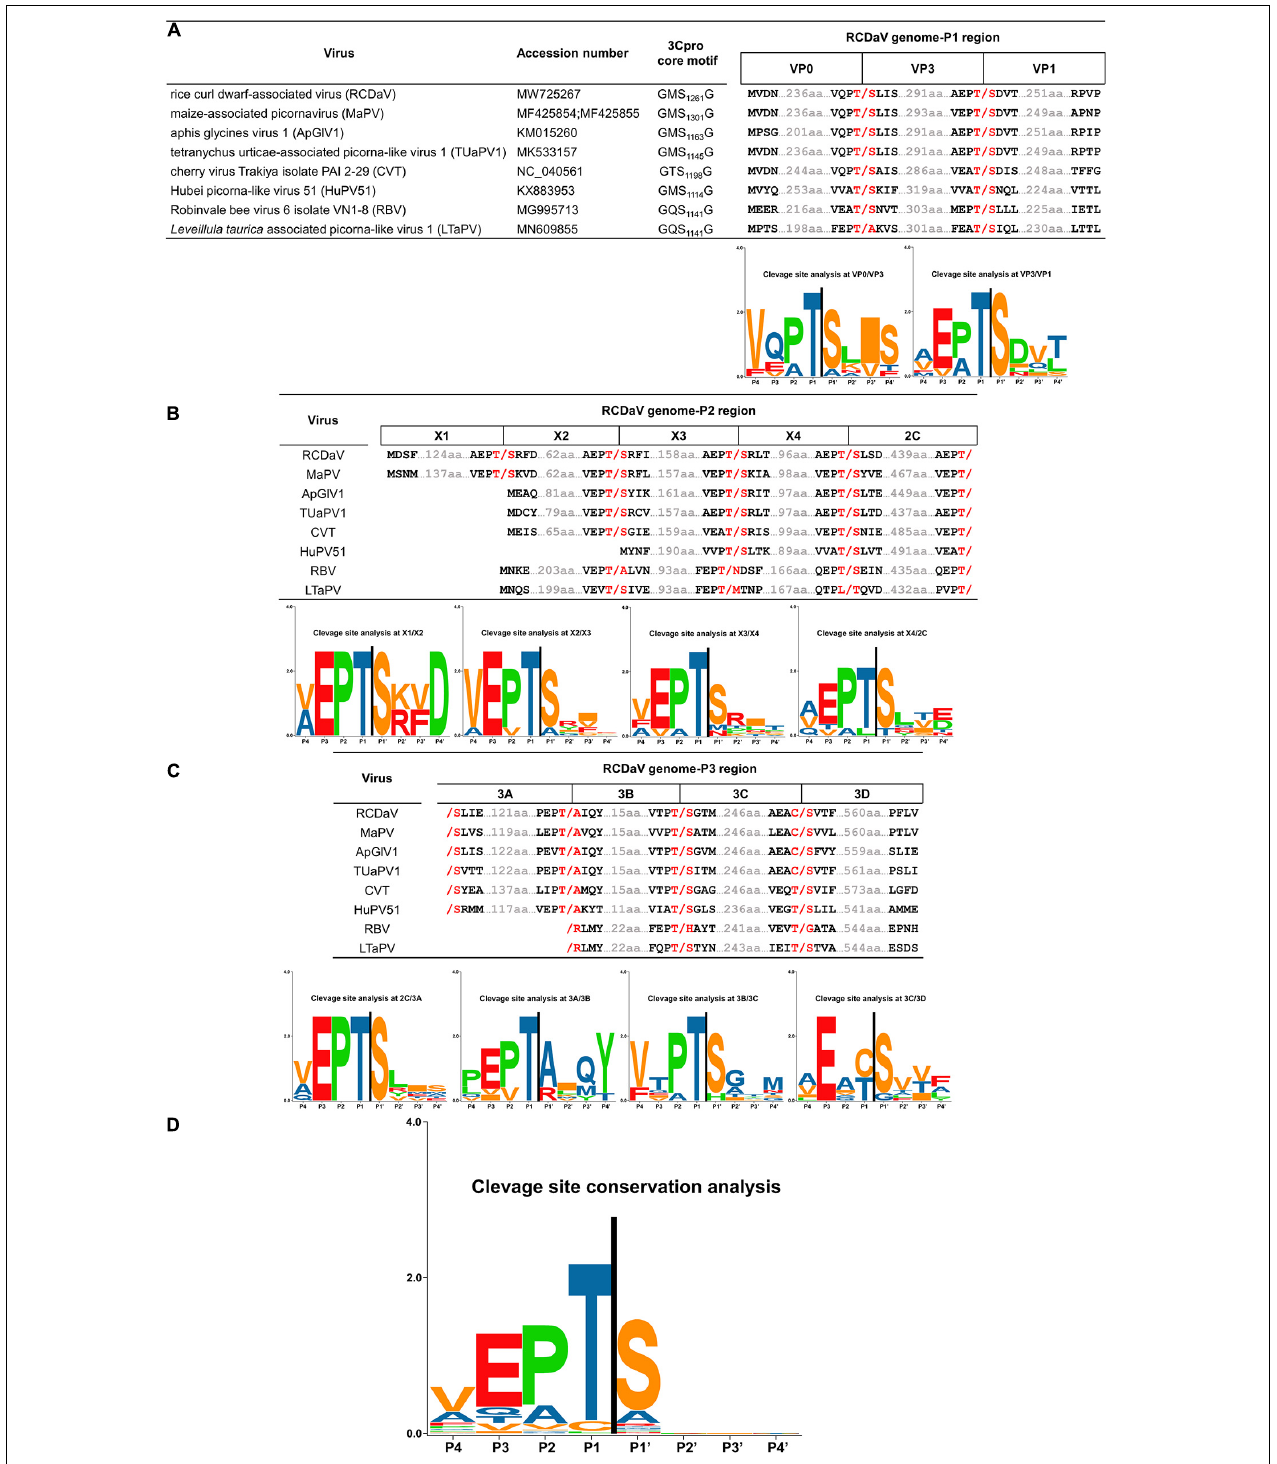
FIGURE 7 | Predicted cleavage sites in polyproteins of the seven unclassified picornaviruses based on rice curl dwarf-associated picornavirus (RCDaV) cleavage sites. (A–C) , Predicted cleavage sites in P1, P2, and P3 regions are shown. The GxSG motif of each virus and conservation analysis of each cleavage sites are also shown. The viral proteins were named according to the cleavage sites, the positions, and the sequence lengths of proteins. Compared with the other viruses, Robinvale bee virus 6 isolate VN1-8 (RBV) and Leveillula taurica associated picorna-like virus 1 (LtaPV) lack the 3A protein. (D) Conservation analysis of all the predicted cleavage sites in the eight picornaviruses. Amino acids are color-coded according to their physicochemical characteristics. Neutral and polar, green; basic, blue; acidic, red; neutral and hydrophobic, black. All amino acids are shown as one-letter standard code.